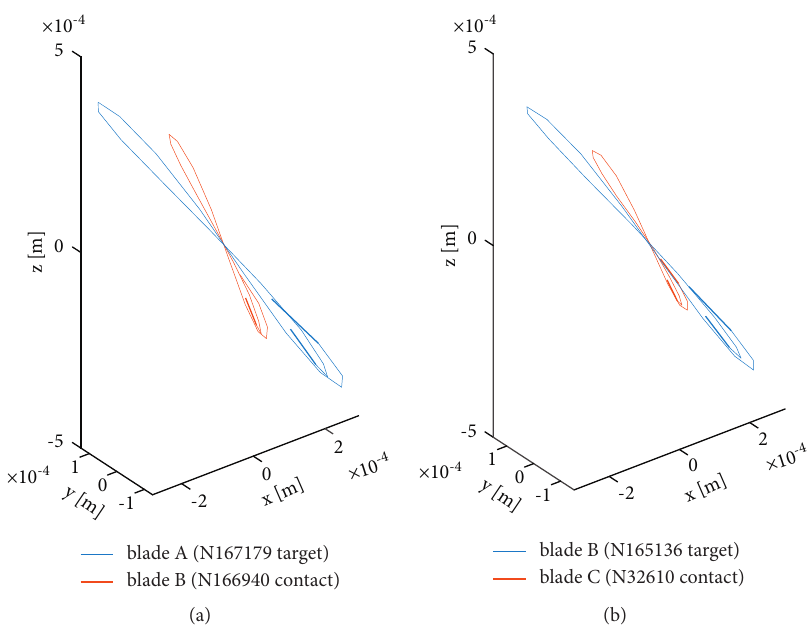
Figure 15: Trajectories of blade motions at contact-target pair nodes in the middle of contact surfaces—2ND mode.